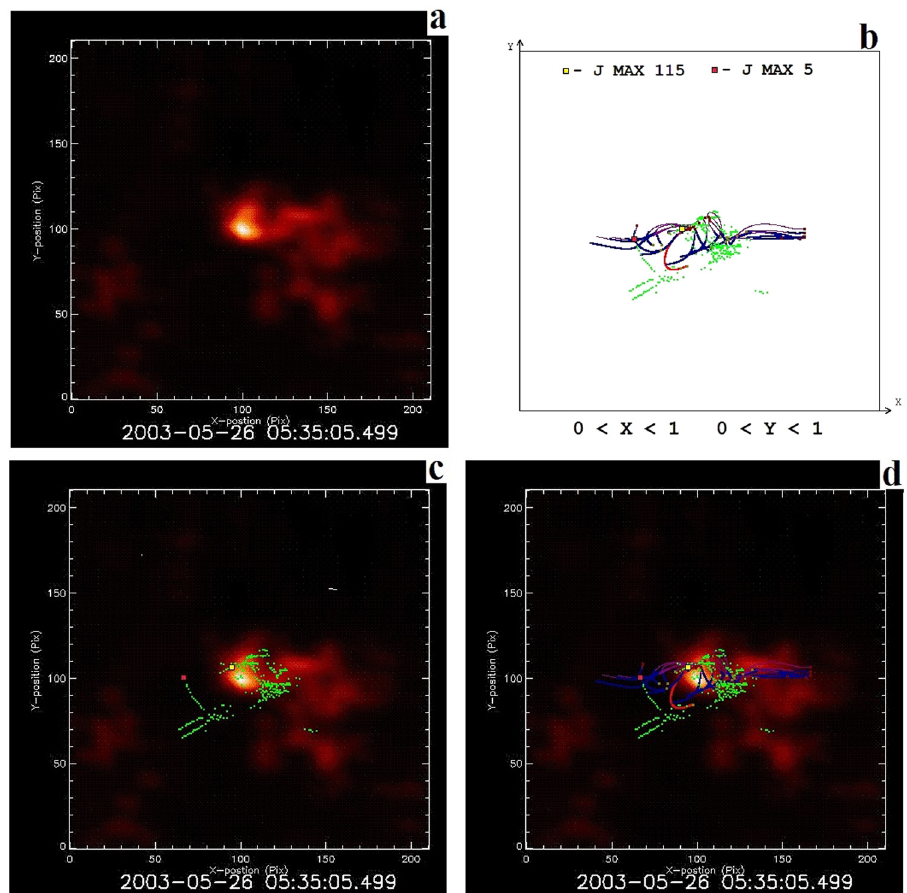
Figure 7: Comparison of the results of MHD simulation with observational data from the NoRH at 05/26/2003 05:34 in a square in the picture plane. Graphical representations are similar to those shown in Figure 5, but di ff erent time ( projections a – d at the time 05/26/2003 05:34 ) . The bold yellow dot shows the position of the 5th maximum, and the bold red dot shows the position of the